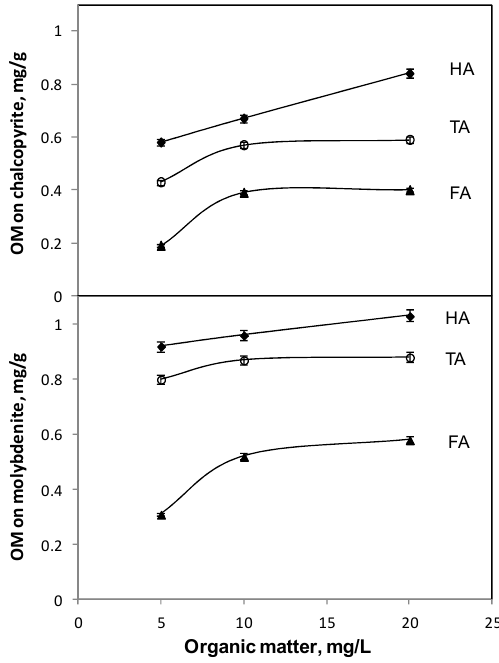
Figure 5. Concentration of OM adsorbed on ( top ) chalcopyrite; and ( bottom ) molybdenite (NaCl 10 − 2 M, pH 9.3). Table 3. Proportion (at.%) of the elements measured by X-ray photoeletron spectrometer (XPS) on the chalcopyrite and molybdenite surface without and with 20 mg/L humic acid (HA). Mineral Condition C O Cu Mo Fe S N No HA 42 Chalcopyrite Molybdenite With HA 29 17 27 8